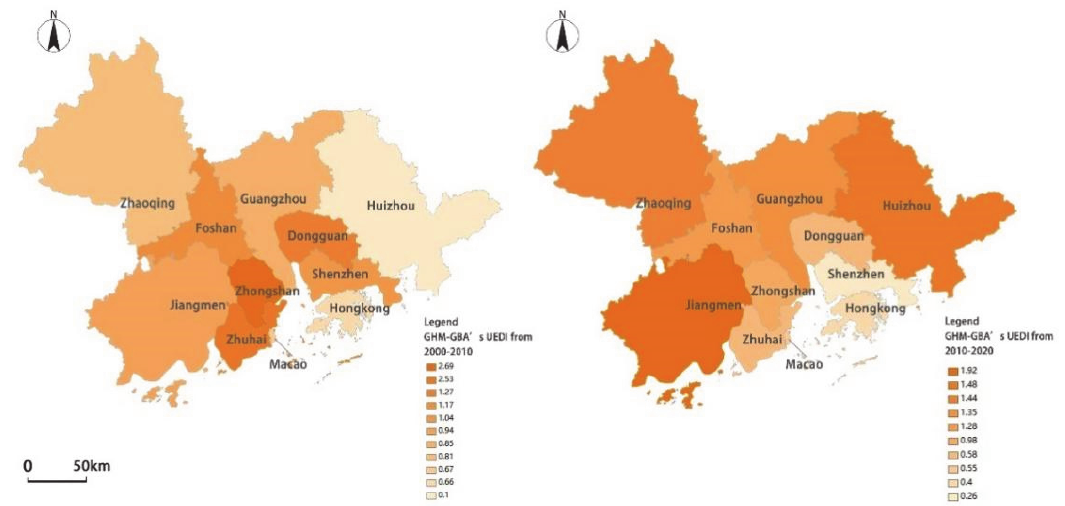
Figure 7. UEDI in the GHM-GBA, 2000–2020.